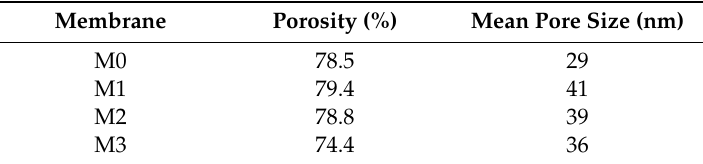
Table 2. Porosities and mean pore sizes of the prepared